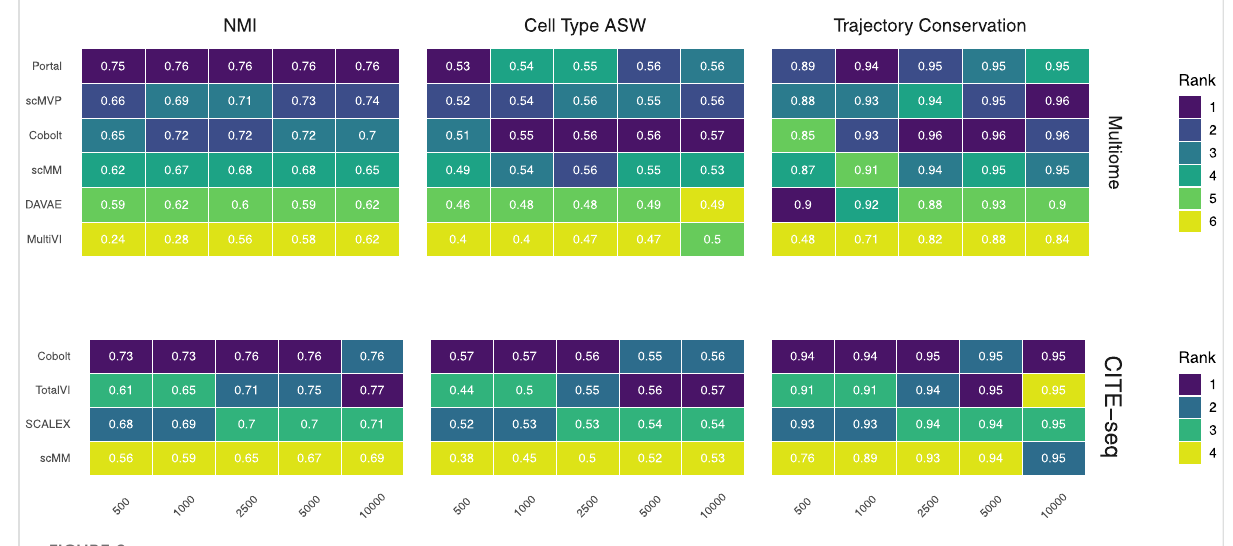
FIGURE 2 Biological preservation metrics. NMI, cell type ASW, and trajectory conservation score indicate the biological preservation quality achieved by joint embeddings from various models. On the 10x Multiome data, the performance of Portal, scMVP, Cobolt, scMM, DAVAE, MultiVI is shown (top), whereas theperformance onCITE-seq dataisshown for Cobolt,TotalVI, SCALEX, andscMM(bottom).Median scoresacrossall iterations areshown inside the